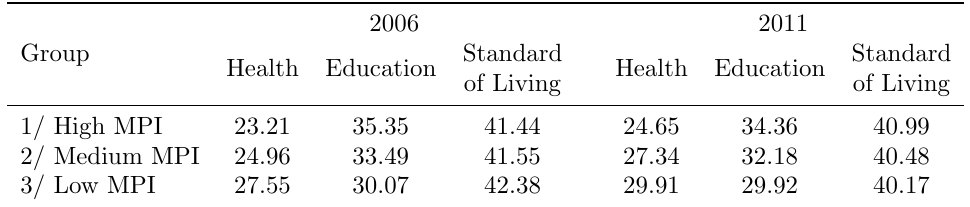
Table 7: Contribution (%) of each dimension to the overall MPI within each group 2006 2011 Group Standard Standard Health Education Health Education of Living of Living 1/ High MPI 23.21 35.35 41.44 24.65 34.36 40.99 24.96 33.49 41.55 27.34 32.18 40.48